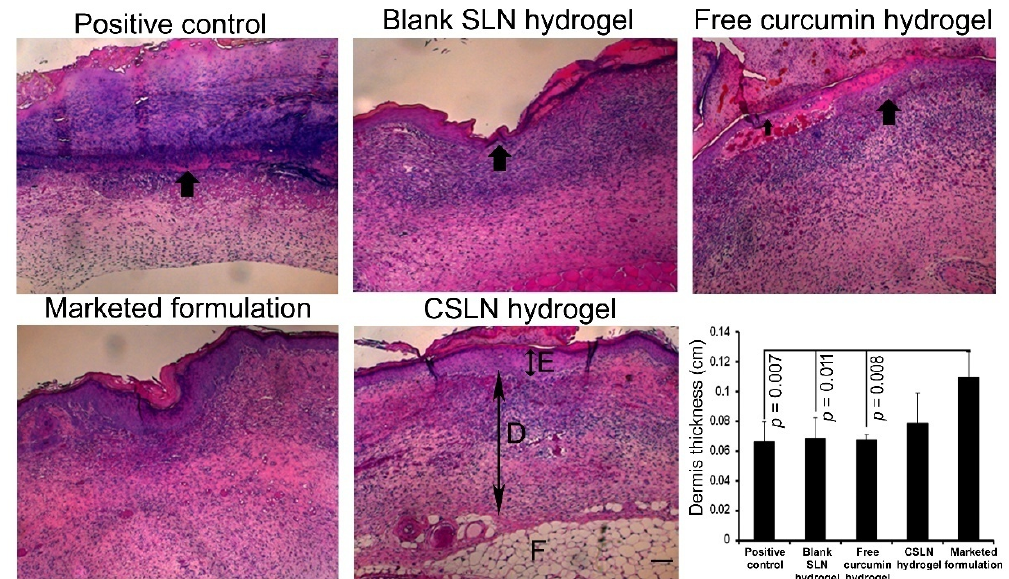
Figure 10. Impact of the CSLN hydrogel on full-thickness excisional wound healing. Representative images of histology of skin wound on day 11 in different treatment conditions (H&E stain) showing the epidermis (E, small double arrow) and dermis (D, large double arrow). Scale bar = 100 cm. Thick black arrows indicate the absence of epidermis and thinner dermal thickness in the positive control, blank SLN hydrogel, and free curcumin hydrogel group of mice. Data are represented as mean ± SEM. Statistical significance determined by ANOVA followed by post-hoc Fisher’s LSD test.